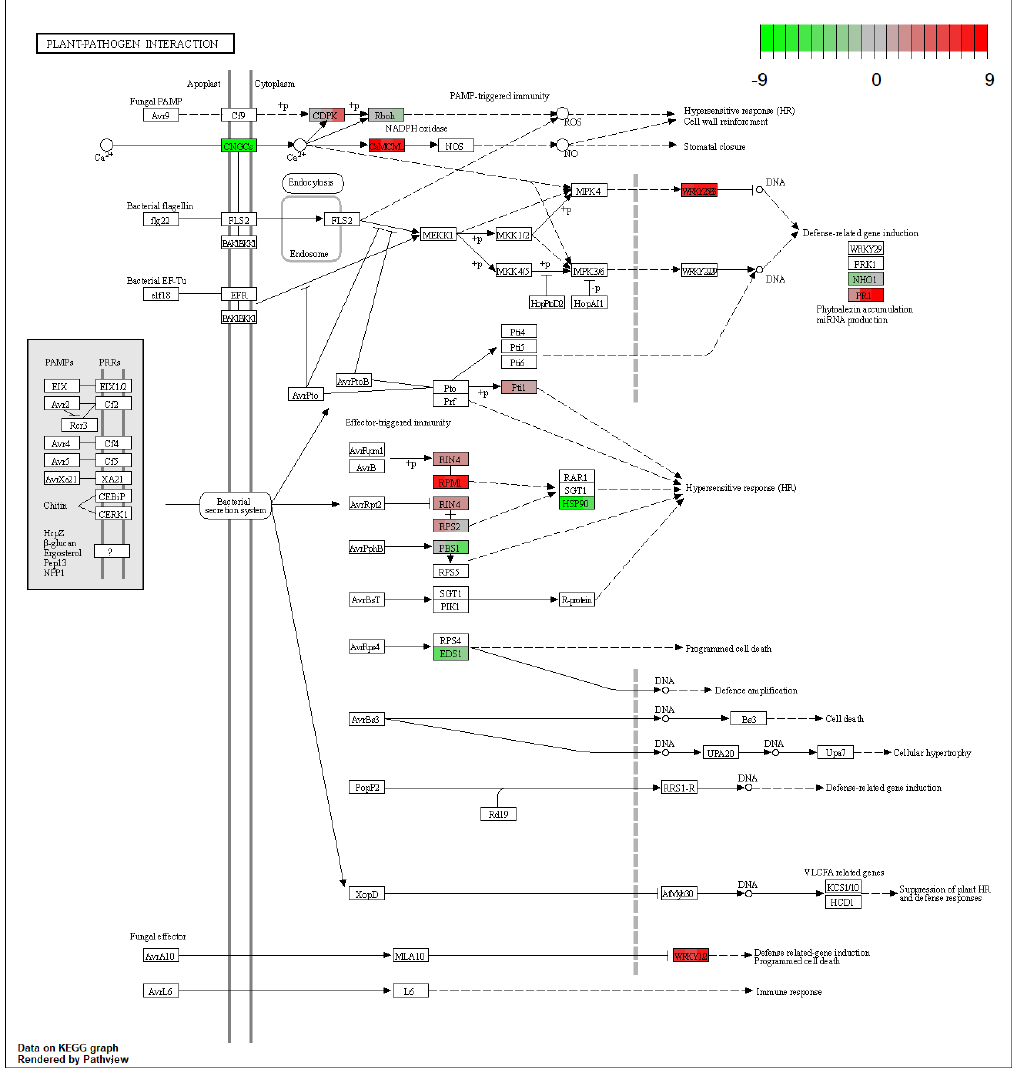
Figure 1. Visualization of KEGG plant–pathogen interaction pathway. Foldchange value of single genes at 1 dpi, 2 dpi, and 5 dpi in M. sieversii infected with V. mali were plotted using pathview package of R/Bioconductor. The nodes are split between different colors, indicating 1 dpi (left), 2 dpi (middle), and 5 dpi (right) data.